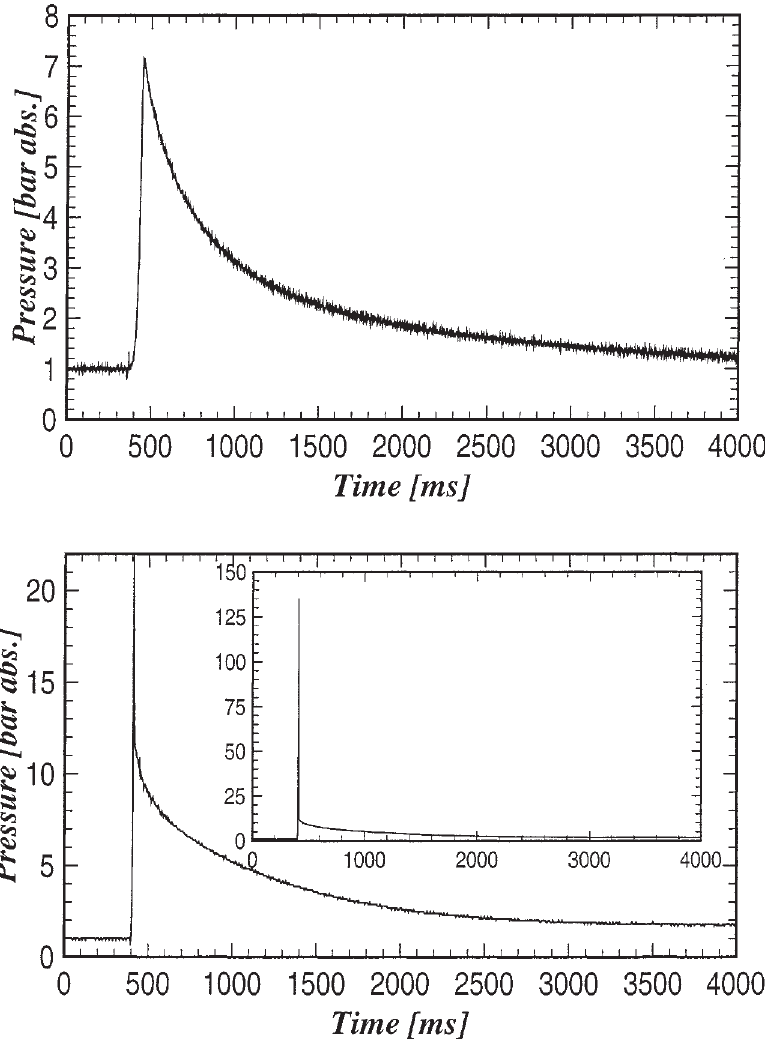
Fig. 1. Differences in the pressure/time trace of a deflagrative (upper diagram) and a detonative explosion (lower diagram). The initial pressure was 1 bar abs in both cases. The maximum rate of pressure rise for deflagrations is typically below 1000 barm/s (normalized for volume), the maximum explosion pressure is typically 7 to 12 times the initial pressure. Detonative explosions exhibit in the leading edge of the pressure/time trace a very high and short pressure pulse associated with a shock wave which does not appear in deflagrations. The pressure rise of this pulse is faster than can be measured with piezoelectric pressure sensors ( > 10 8 bar/s), the height of the pulse depends on the kind of gas and the geometry of the gas volume (here 135 times the initial pressure was attained, the gas was CH 3 -O-NH 2